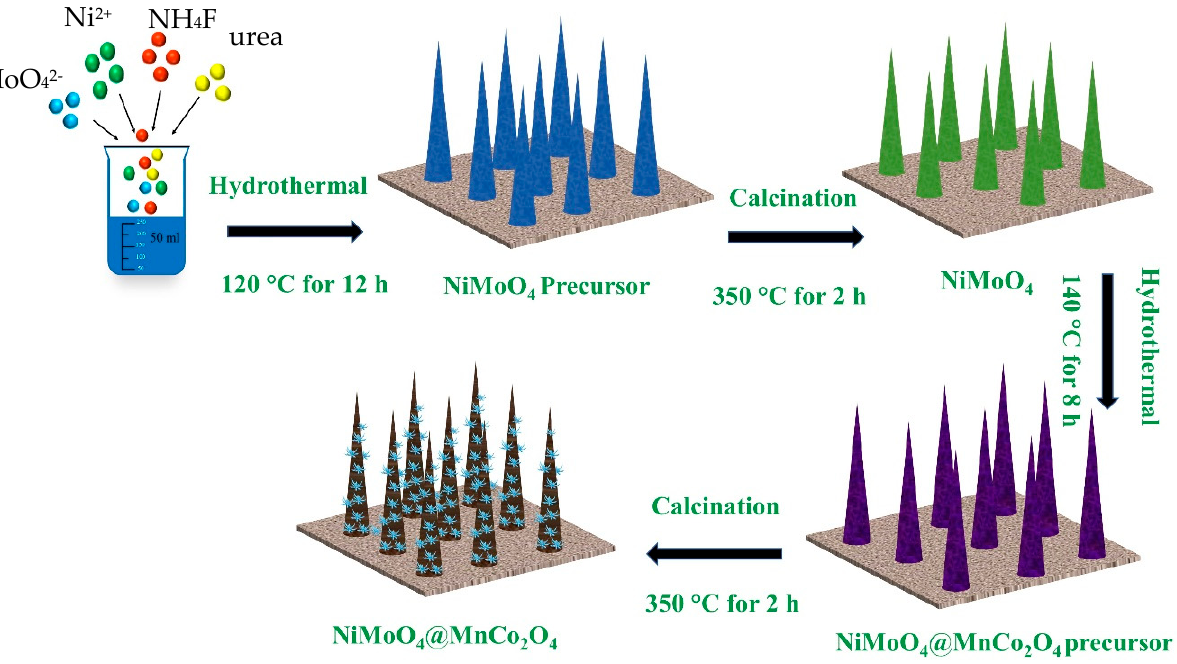
Figure 1. Synthesis schematic of NiMoO 4 @MnCo 2 O 4 composite electrode.